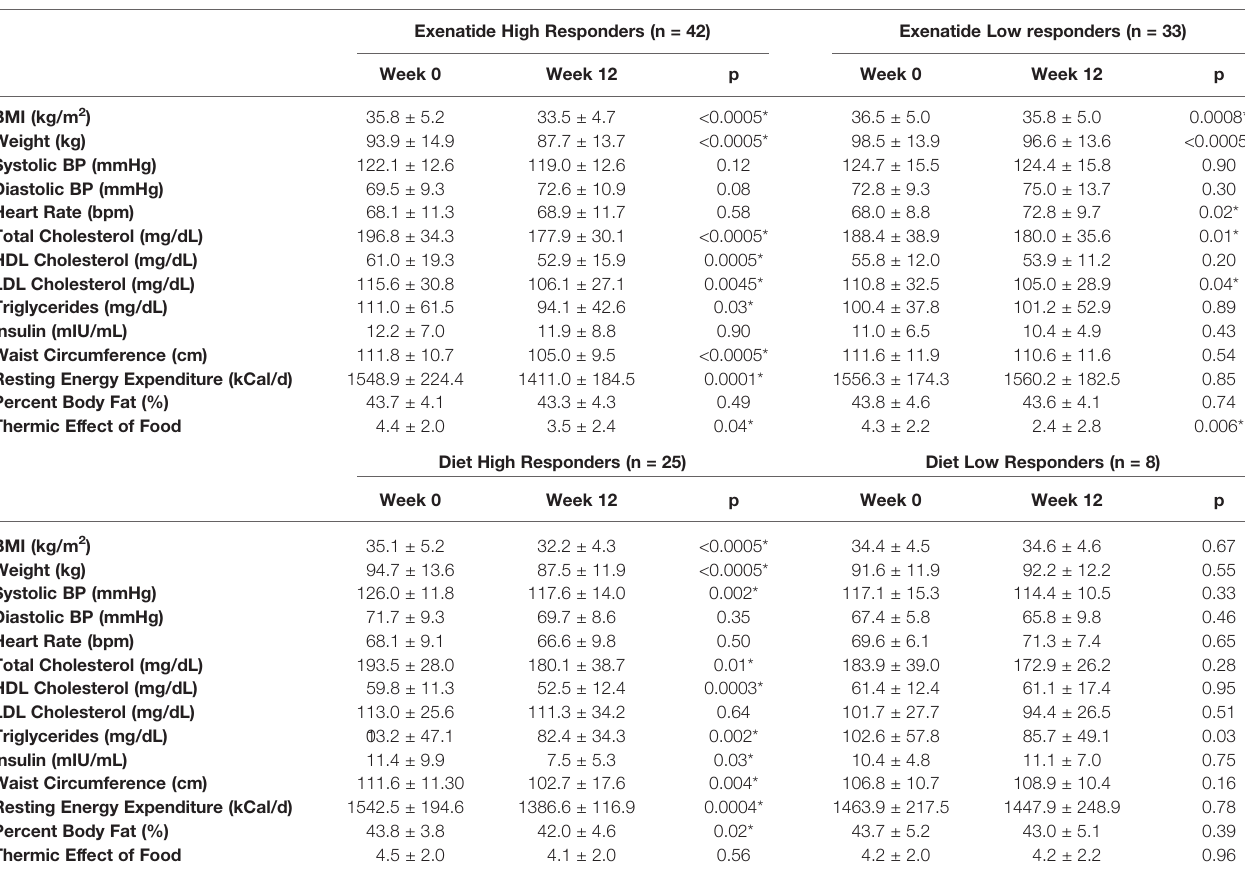
TABLE 2 | Characteristics of all 4 study groups before and after 12 weeks of treatment with exenatide or diet.